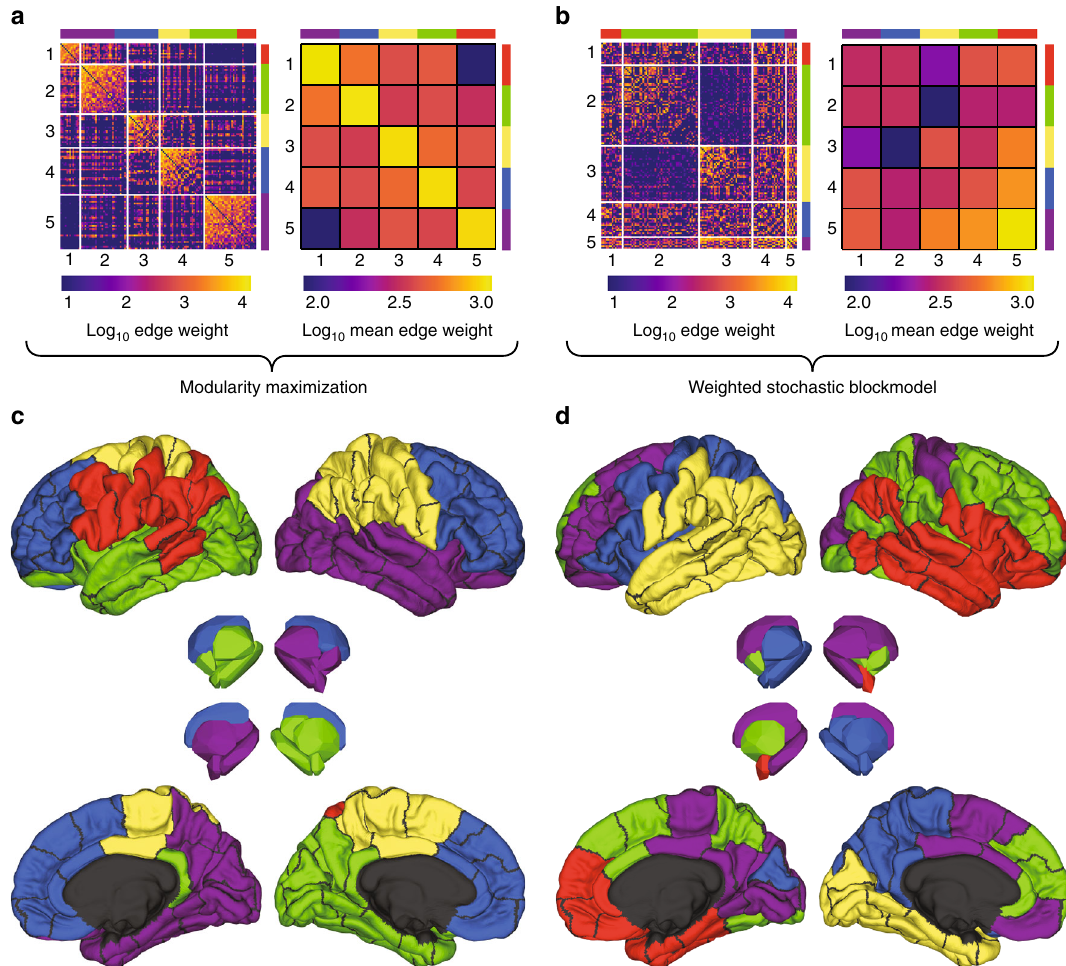
Fig. 2 Example WSBM and Q max communities. Human connectome network ordered by community partitions detected using a Q max and b the WSBM. Both examples are shown with the number of communities fi xed at K = 5. The color of matrix elements for the left sub-panels represents log-transformed edge weights while the color of matrix elements for the right sub-panels represents the log-transformed mean within-community and between-community edge weights. Panels c and d depict the spatial distributions of those same